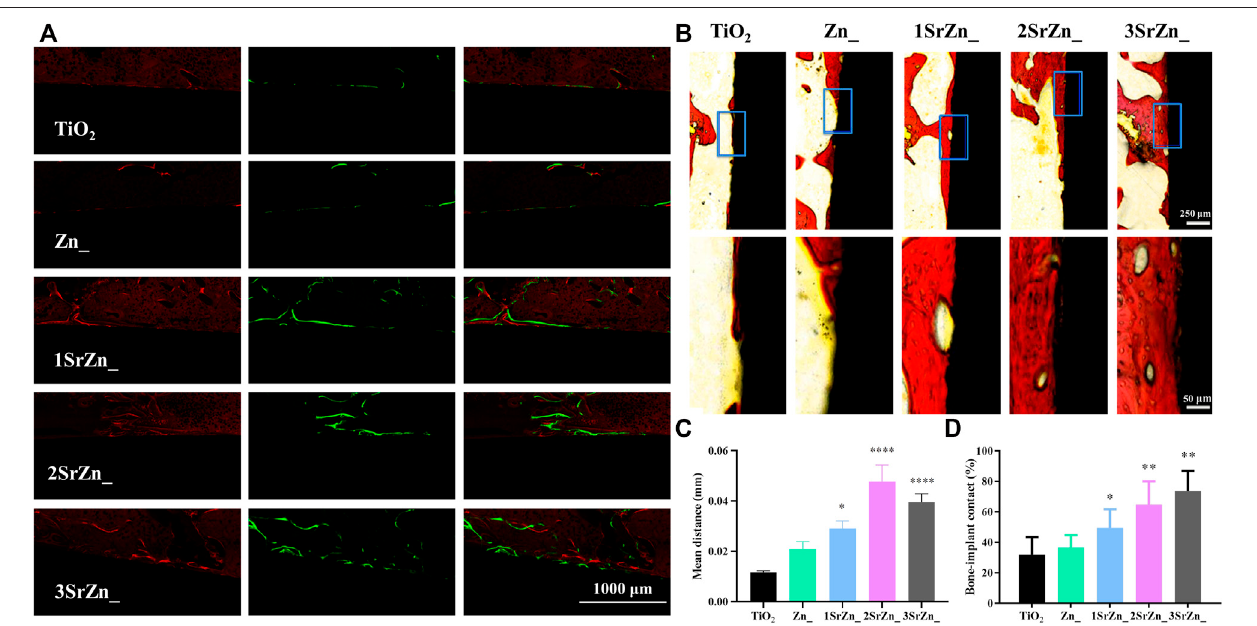
FIGURE 7 | In vivo osseointegration. (A) Bone formation and deposition around the implant samples by polychrome sequential fl uorescent labeling method; listed from left to right: alizarin red labeling (red) at 2 weeks and calcein (green) at 6 weeks after surgery of bone tissue and the merged image. (B) Van Gieson ’ s staining of the sections fromratsat 8 weeksafterimplant surgery. (C) Themeandistancebetweenthetwolabeling linesofalizarinredand calcein(redandgreen)in (A) wascalculated by ImageJ compared with the TiO2 group. (D) Quanti fi cation of the bone implant contact (BIC) level of the staining in (B) compared with the TiO2 group.